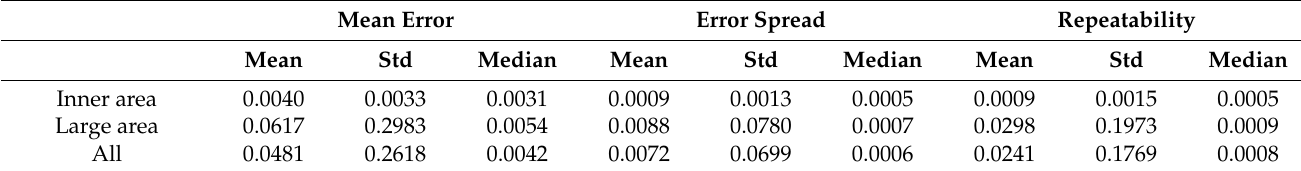
Table 2. Mean, standard deviation, and median of orientation error metrics.